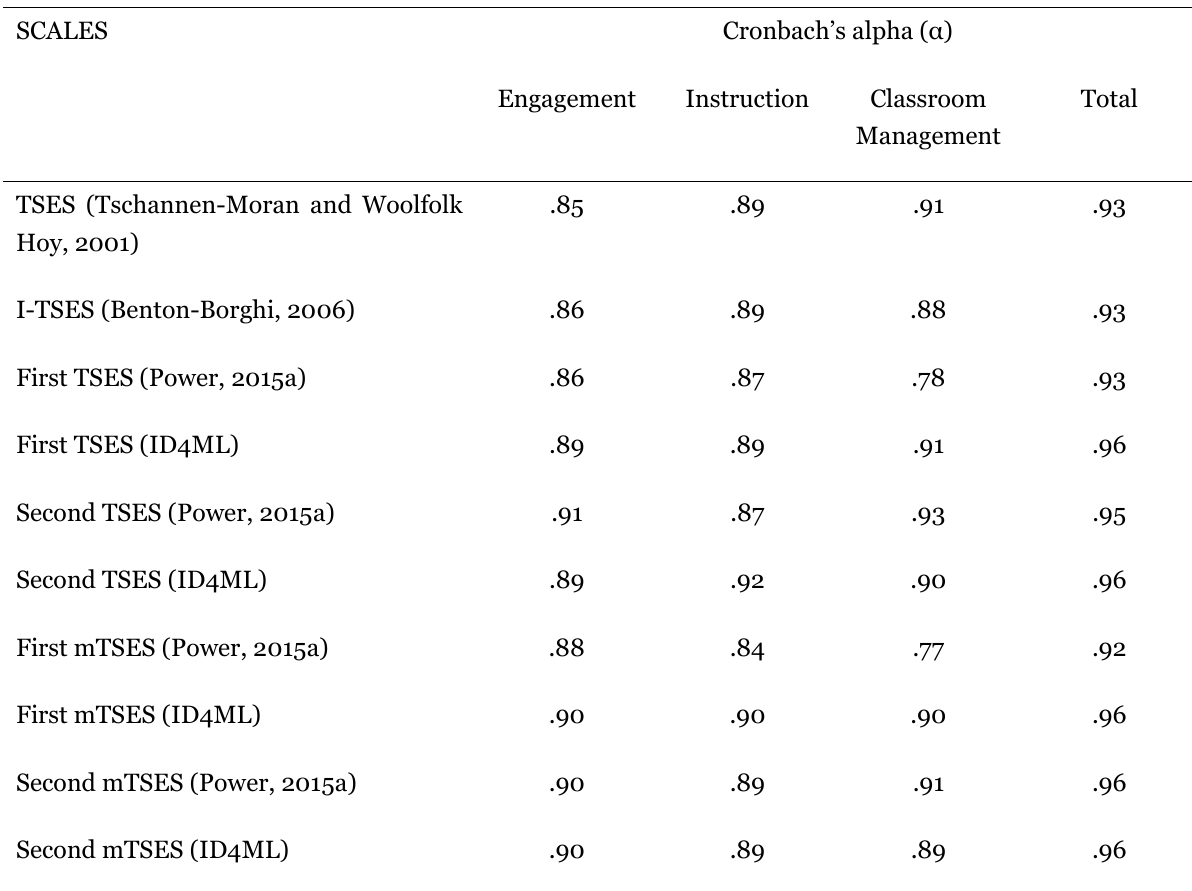
TSES, I-TSES and mTSES Reliabilities (Cronbach's alpha)